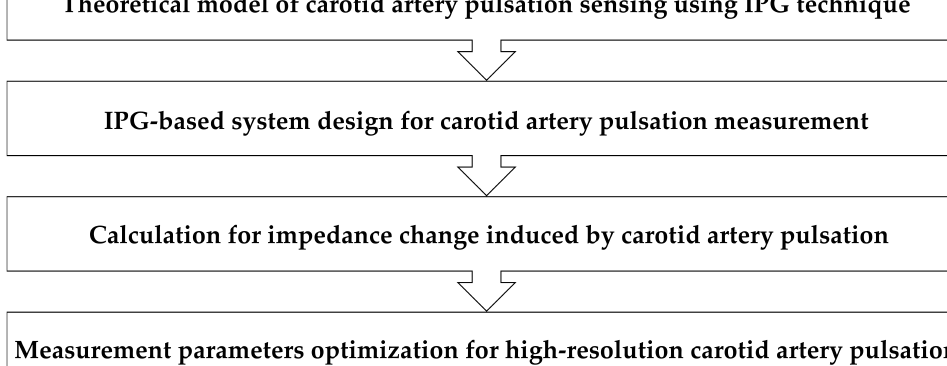
Figure 1. Flow chart of the IPG methodology for carotid pulse